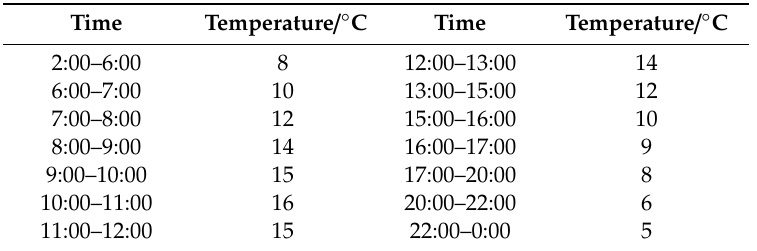
Table 4. Seawater temperature in each time period.